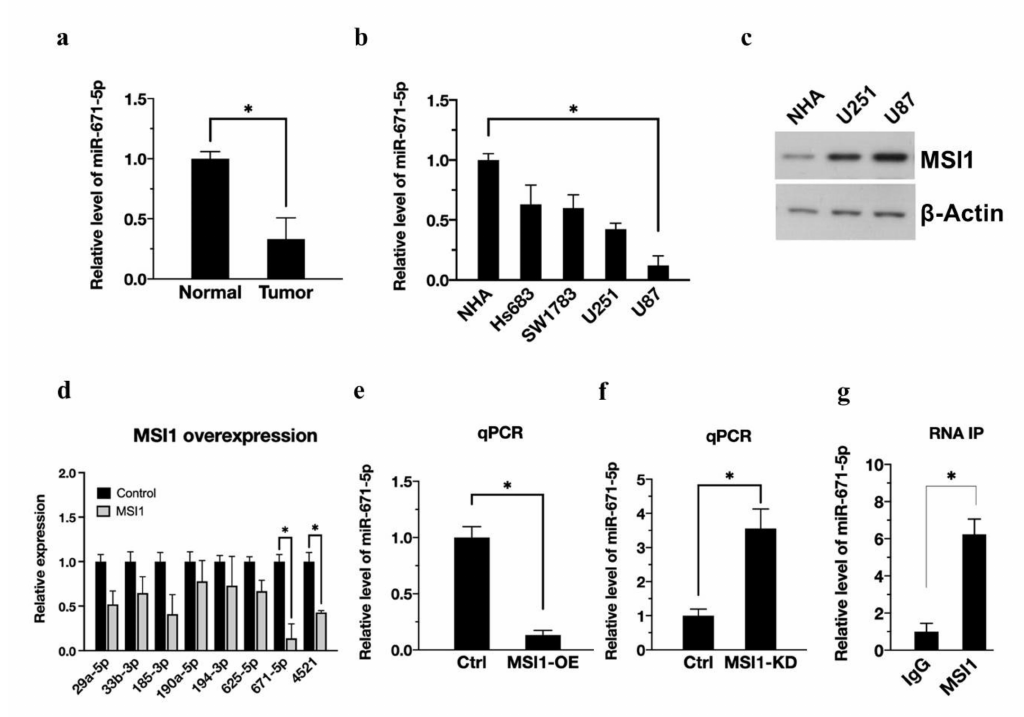
Figure 1. MSI1 activation downregulates miR-671-5p expression. ( a ). qRT-PCR analysis of expression of miR-671-5p in clinical tumor cells compared to the adjacent normal group. The miR-671-5p level is presented as a mean from three independent experiments with SD error bars. An asterisk indicates a statistically significant difference (Student’s t -test, p < 0.01). ( b ) qRT-PCR analysis of expression of miR-671-5p in Hs683, SW1783, U251, and U87MG cells compared to control NHA group. ( c ) Western blotting analysis of expression of MSI1 in NHA, U251, and U87MG cells. ( d ) qRT-PCR analysis of expression of miRNAs in MSI1-overexpressed U87MG cells compared to control group. ( e ) qRT-PCR analysis of expression of miR-671-5p in MSI1-overexpressed or ( f ) MSI1-knockdown U87MG cells compared to control cells. ( g ) RNA-IP analysis of MSI1-interacted miR-671-5p compared to that in the IgG group. The miR-671-5p level is quantified relative to the IgG group and presented as a mean from three independent experiments with SD error bars. An asterisk indicates a statistically significant difference (Student’s t -test, * p <